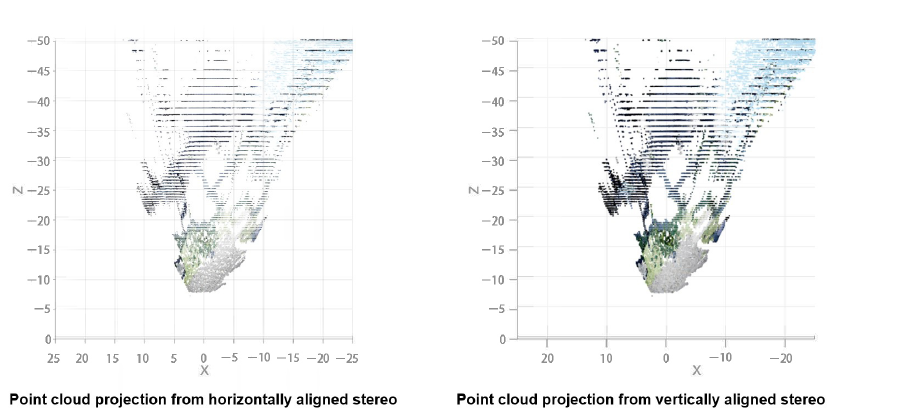
Figure 12. Comparison of point cloud projected from horizontal stereo configuration ( left ) with vertical stereo configuration ( right ). No major dissimilarity is observed in terms of range